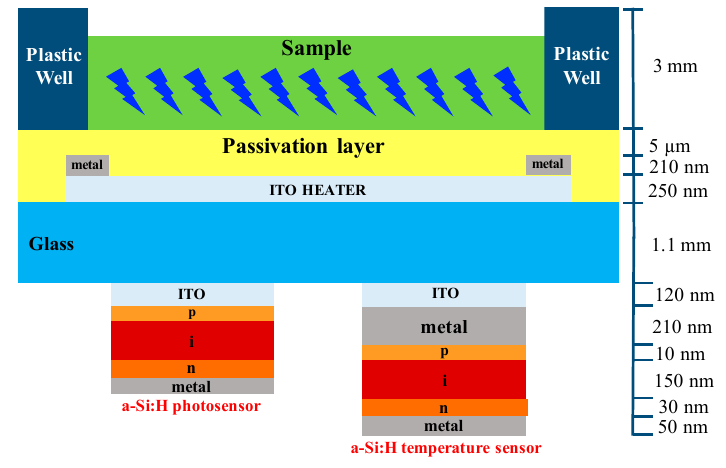
Figure 1. Cross section of the proposed system: The glass substrate hosts the transparent ITO heater on the top side and the a-Si:H sensors on the bottom side. The photosensor ( left ) and temperature sensor ( right ) differ for the bottom contact: ITO for the photosensor and a stack of ITO and metal (TiW) for the temperature sensor. The plastic well, with transparent bottom, contains the biological sample where the BL emission (blue arrows)